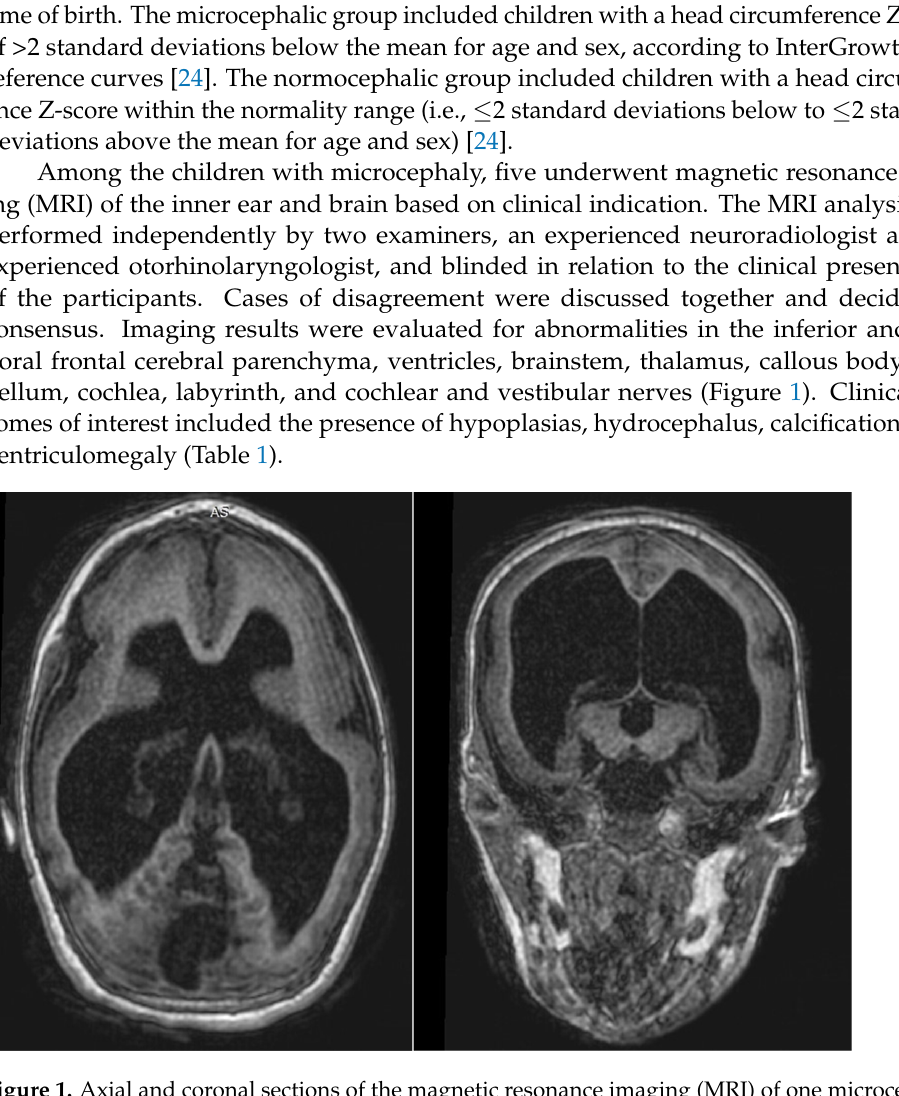
Figure 1. Axial and coronal sections of the magnetic resonance imaging (MRI) of one microcephalic child from this study.